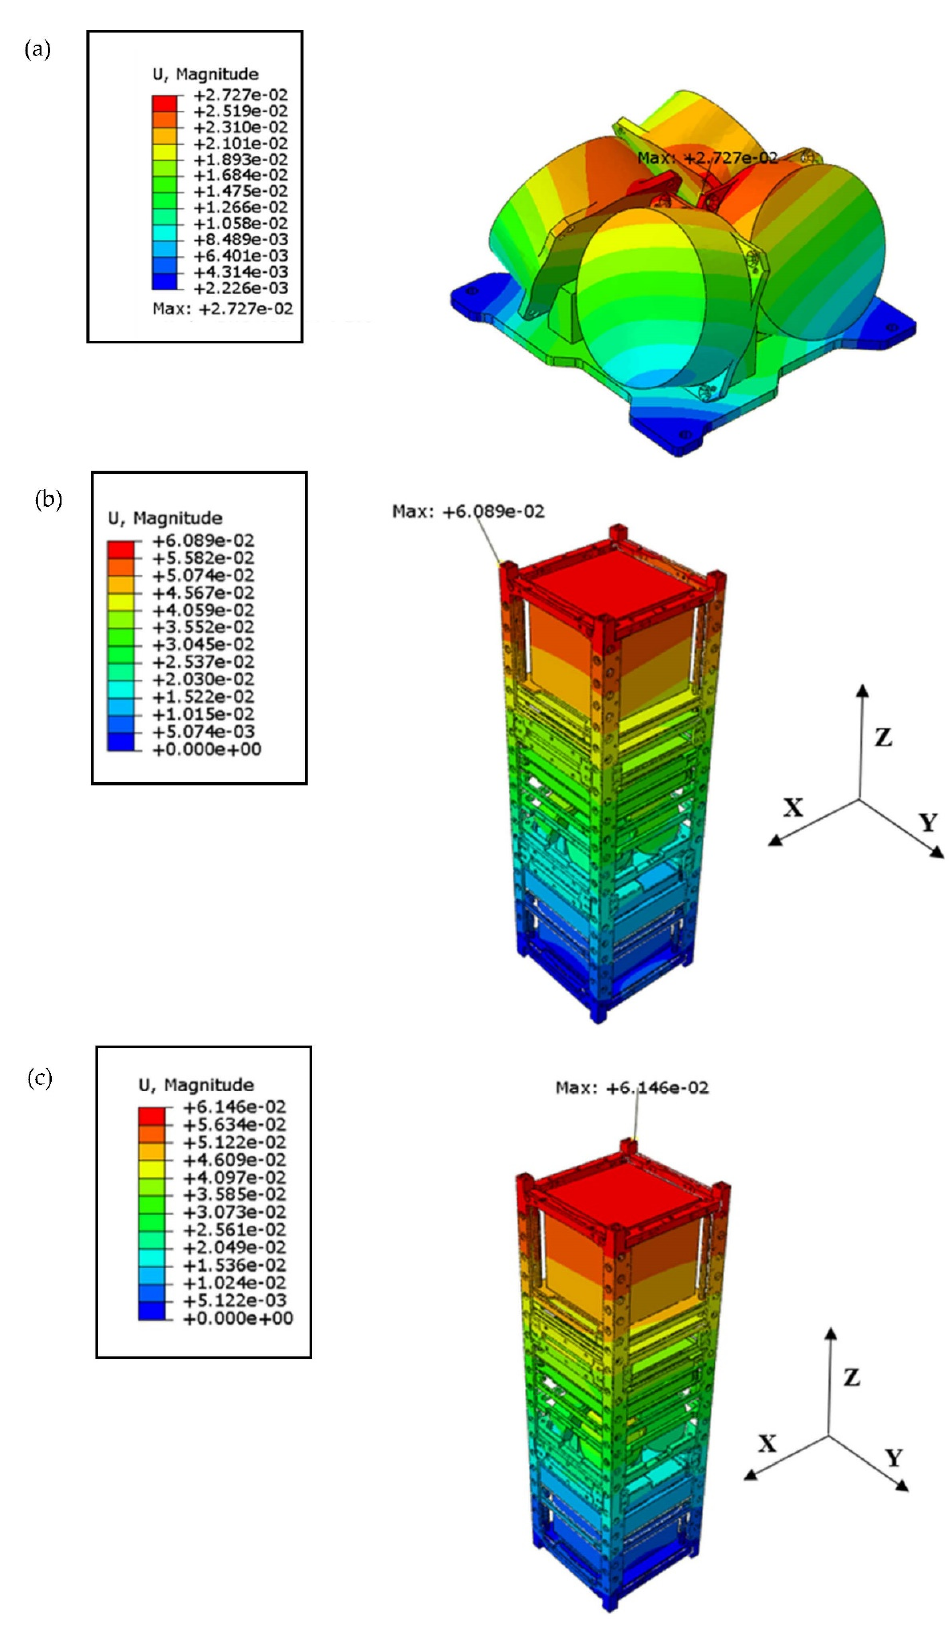
Figure 16. Maximum deformation ( mm ): ( a ) Case A; ( b ) Case B; ( c ) Case C.